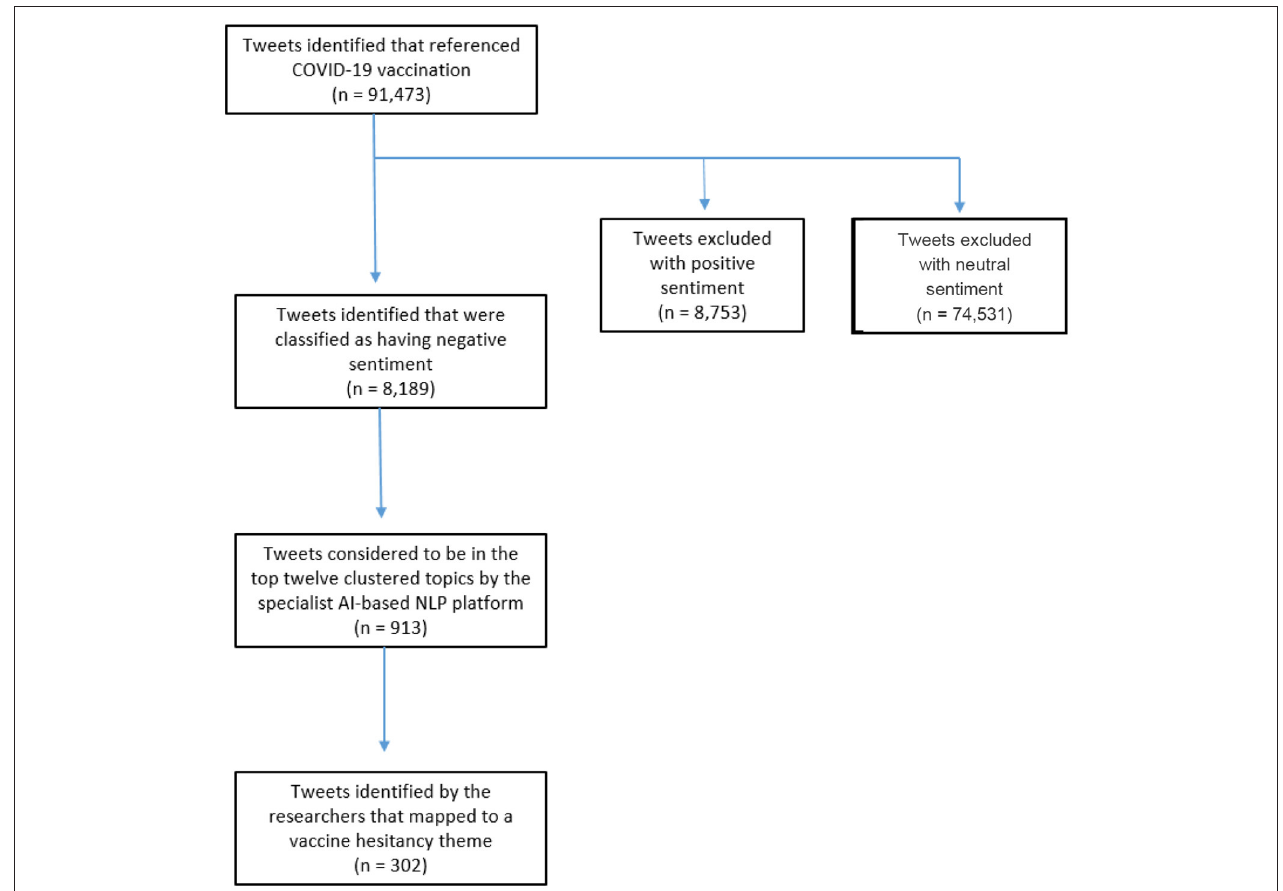
FIGURE 1 | Search strategy and Tweet selection flow